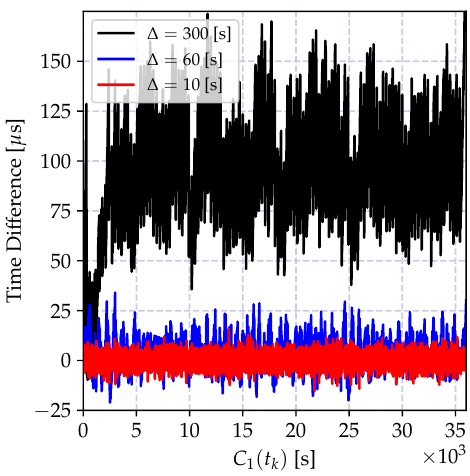
Figure 8. The time difference in microseconds between the time reports of a local clock and a reference clock when only the time relation parameters of the progressive time model with the message delivery delay are estimated at different periods ∆ using linear regression with a regression table of N = 8